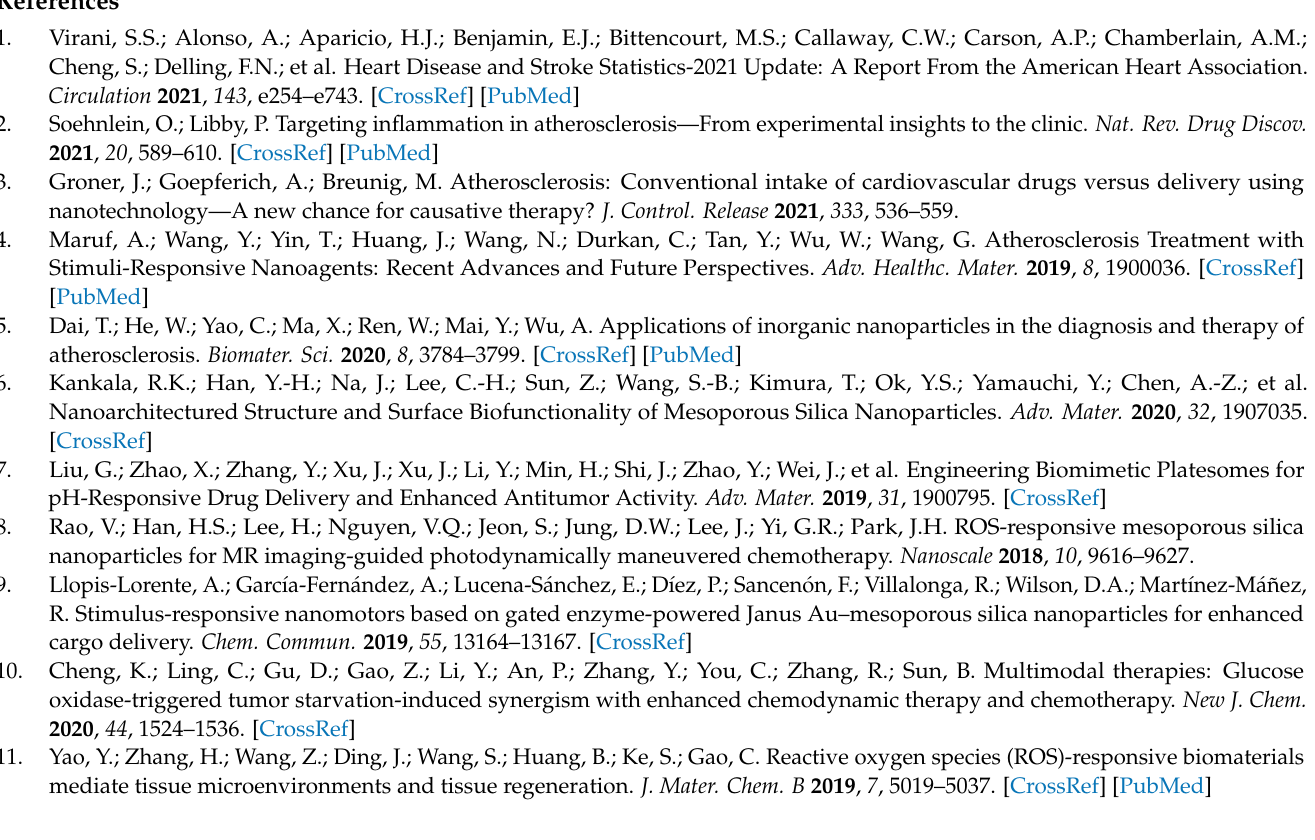
Figure S8: (A) Confocal laser microscope images of LPS- and oxLDL-treated RAW 264.7 cells co- incubated with NR@HA-MSN for 1 h, 2 h, 4 h, 8 h. (B) Corresponding mean fluorescence intensity of dye after cellular internalization ( n = 3). Figure S9: The organ index of mice after treatment with